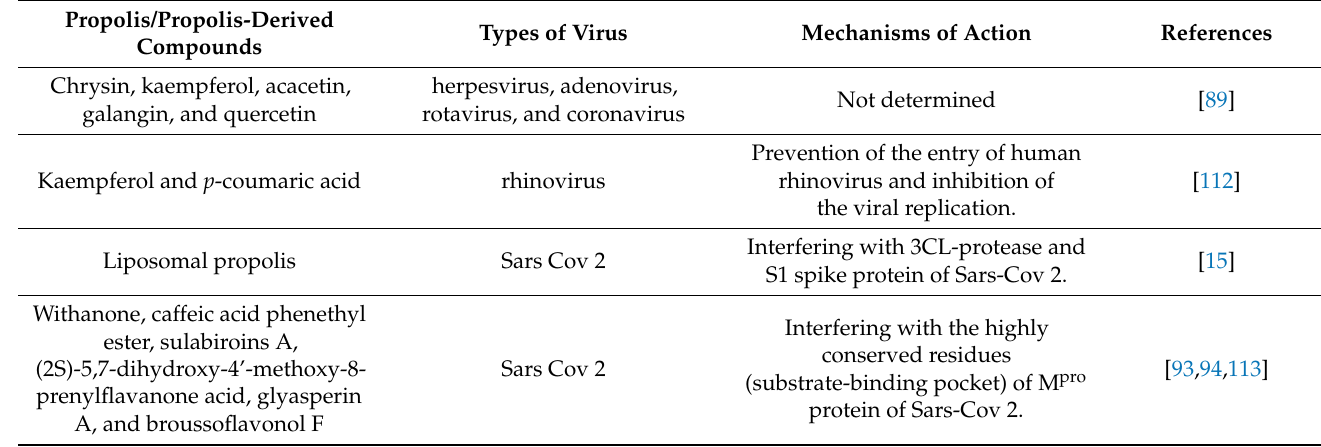
Table 3. Antiviral properties of